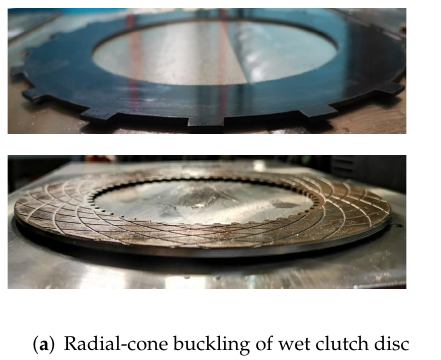
Figure 1. Common disc deformation types in a wet